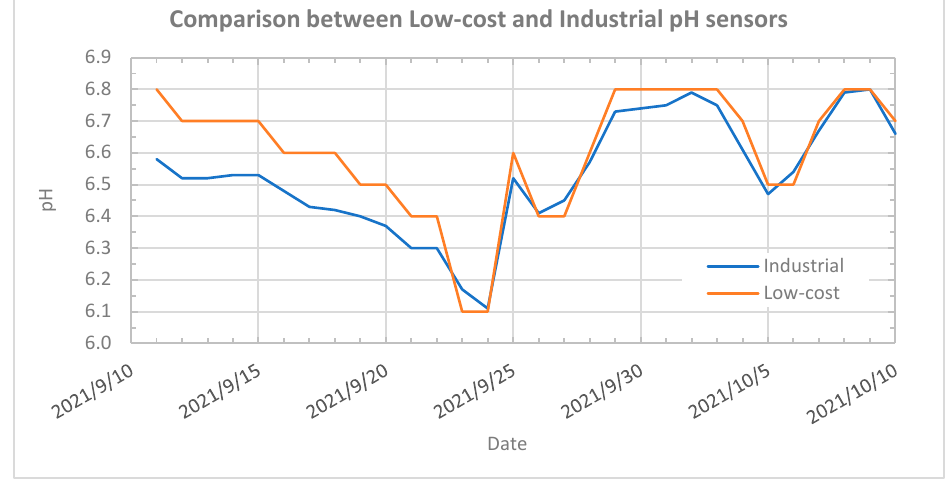
Figure 3. Comparison of industrial and low ‐ cost pH sensors’ measurements.